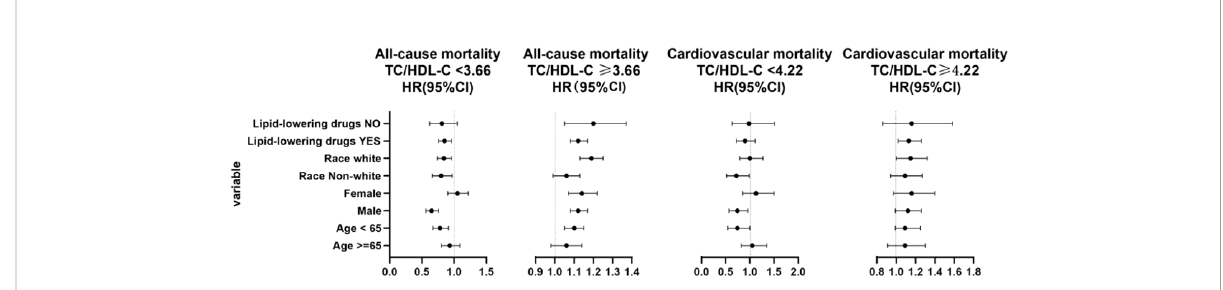
FIGURE 4 Subgroup analysis of the total cholesterol/high-density lipoprotein cholesterol (TC/HDL-C) ratio based on cutoff value. When analyzing a subgroup variable, age, gender, race, smoking, body mass index, systolic blood pressure, estimated glomerular fi ltration rate, total cholesterol, comorbidities (diabetes and hypertension), and medicine use (antihypertensive drugs, hypoglycemic agents, and lipid-lowering drugs) were adjusted except the variable